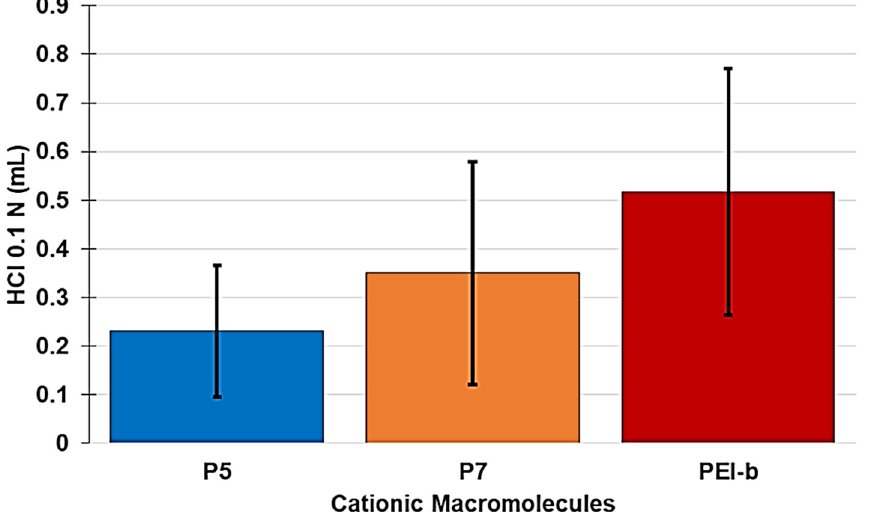
Figure 4. Average buffer capacity of P5, P7 and PEI- b 25 kD.